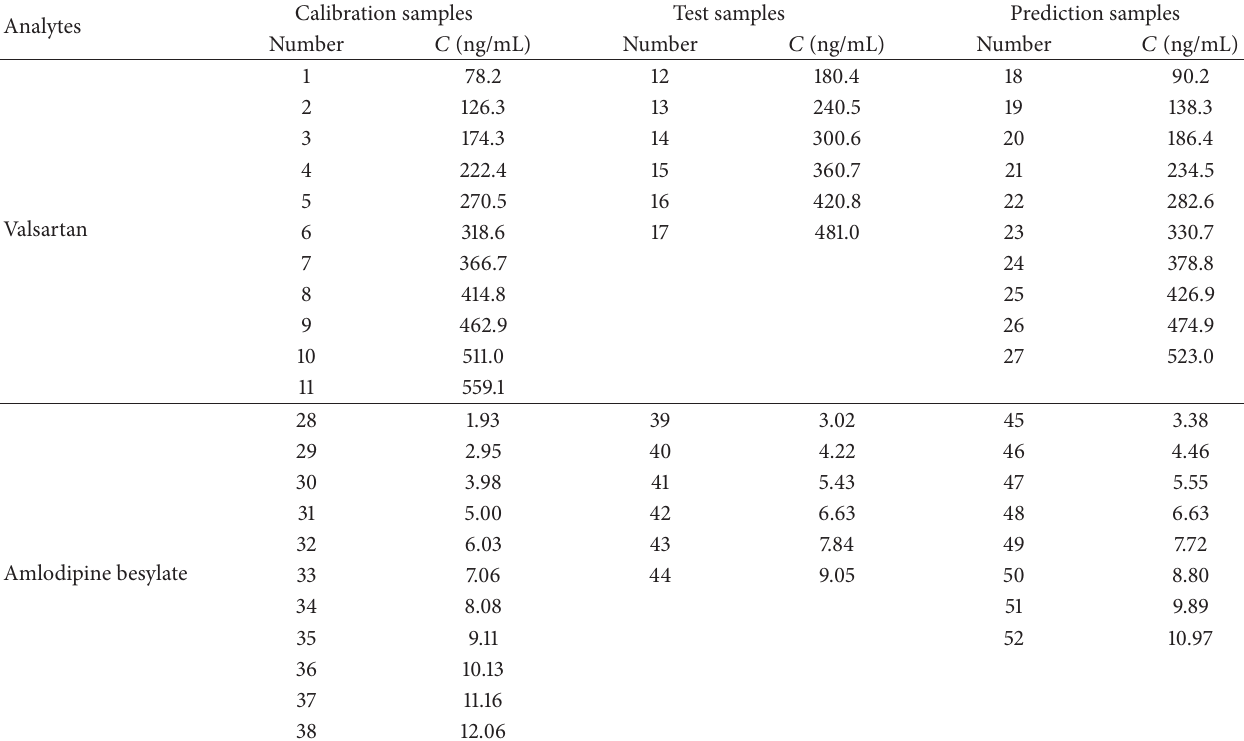
Table 1: The concentration of valsartan and amlodipine besylate in calibration, test, and prediction samples.